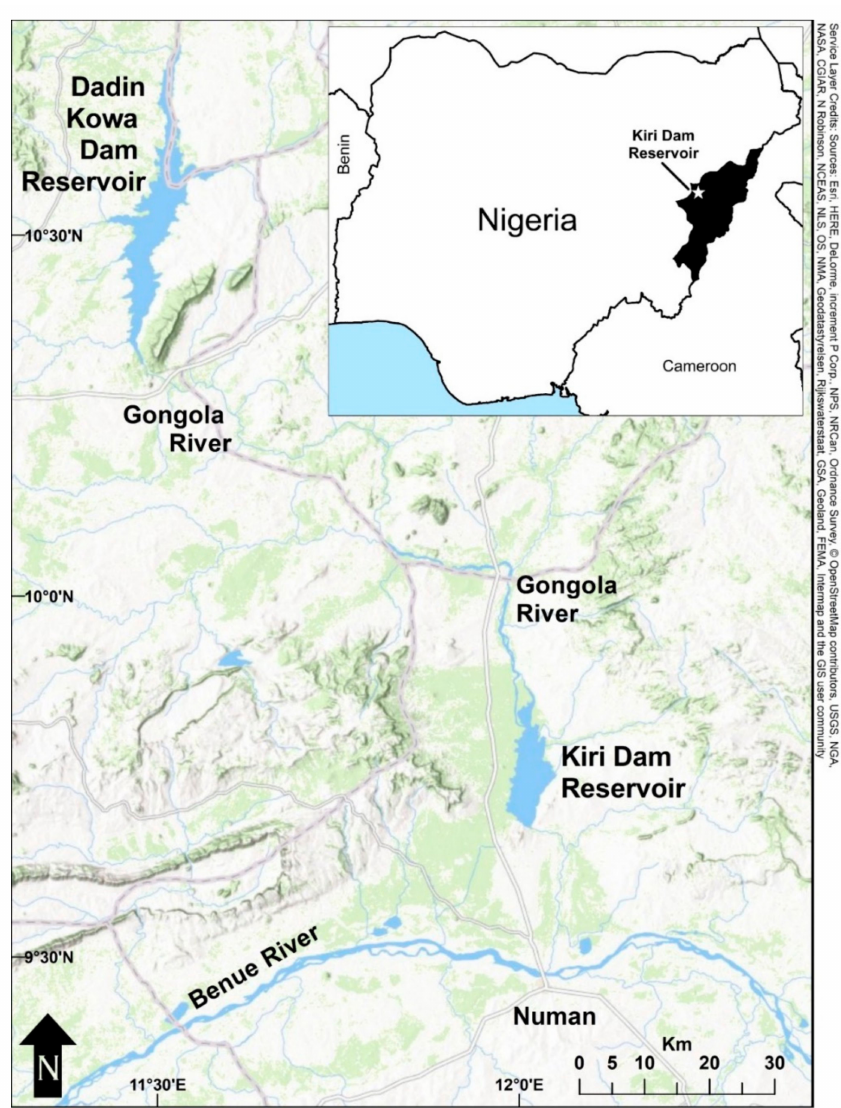
Figure 1. Kiri Dam is located at the confluence of the Benue and Gongola Rivers in Adamawa State, and downriver of Dadin Kowa Dam in Gombe State, in northeastern